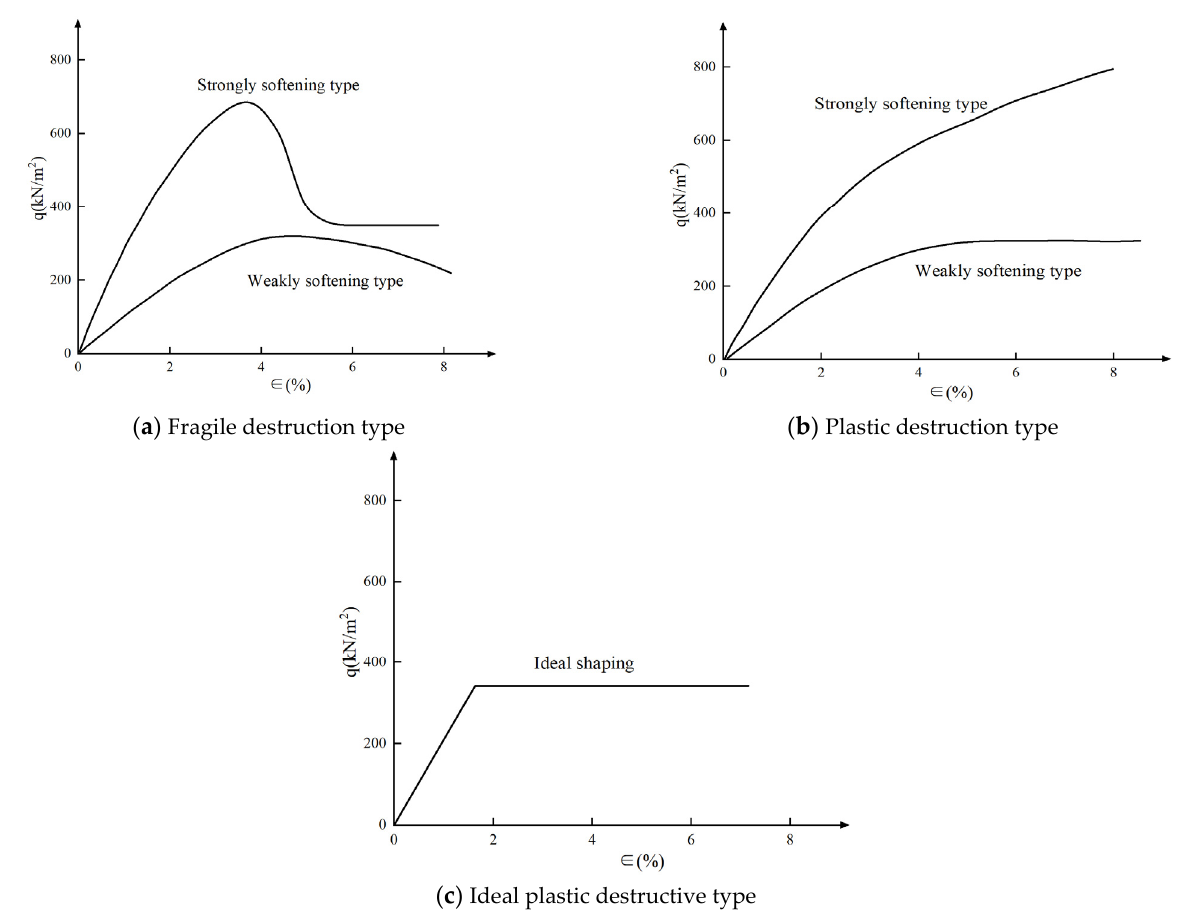
Figure 9. Schematic diagram of the stress and strain curve type .